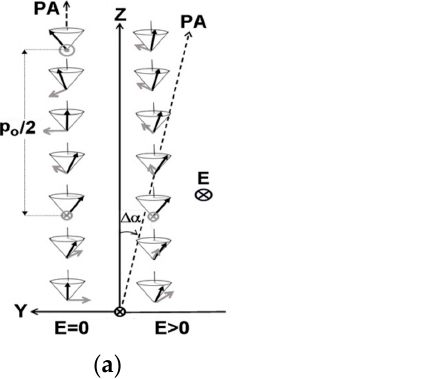
Schematic representation of the refractive indices ellipsoid in the absence (left) and in the presence (right) of